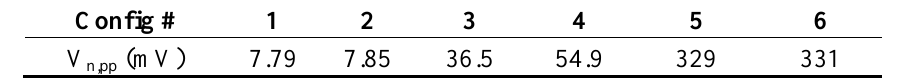
node in the test circuit in Figure hpf